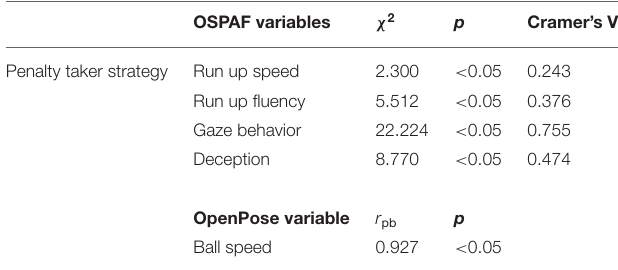
TABLE 3 | Test-retest reliability per variable.